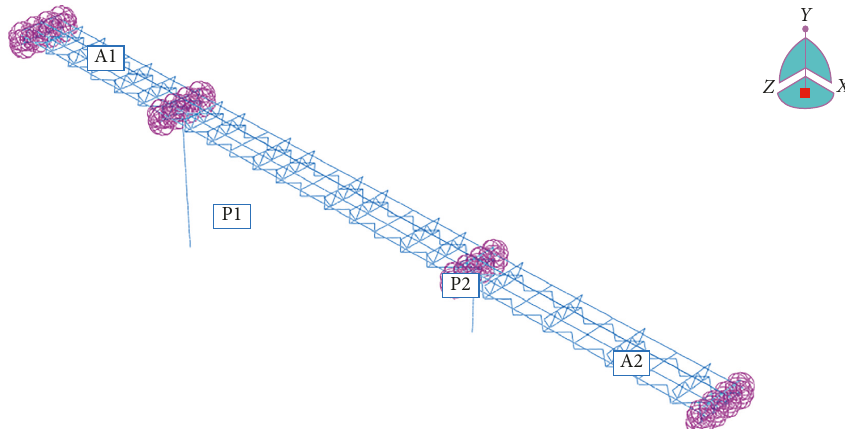
Figure 30: Location of